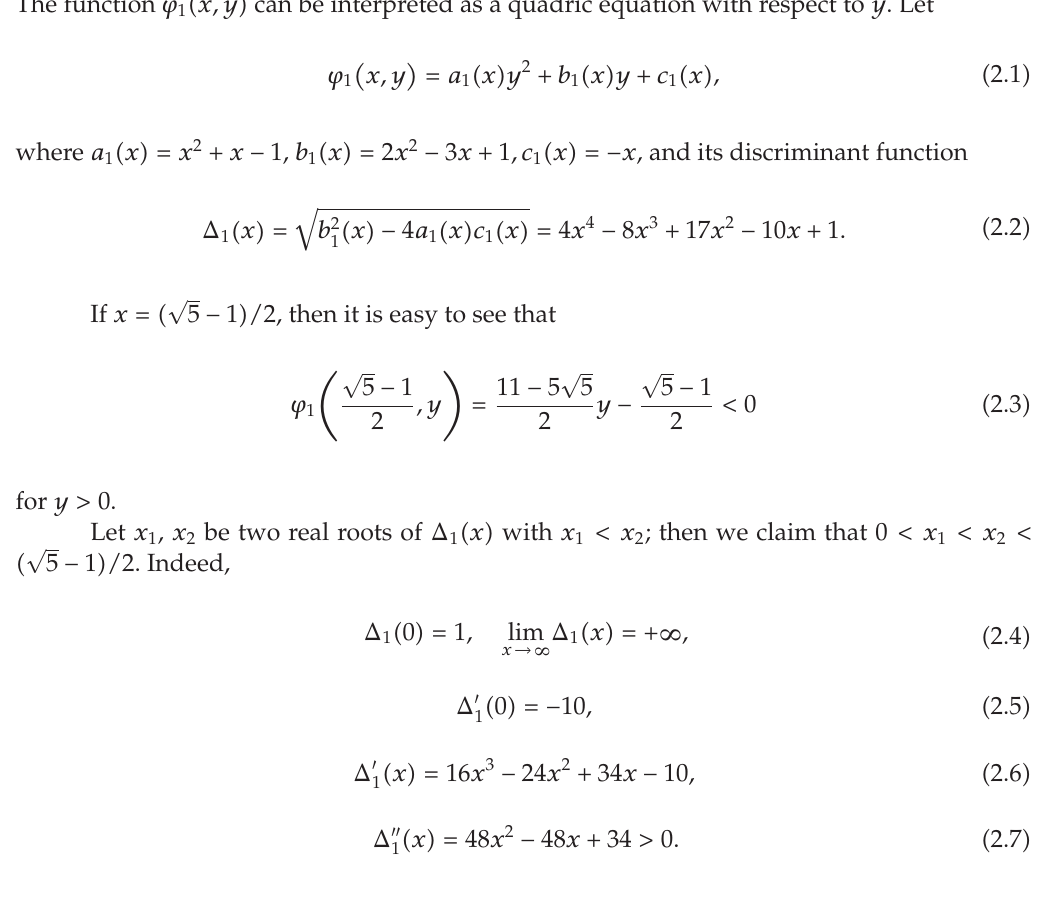
∪ Ω , and (cid:7) f α,β (cid:2) x (cid:3)(cid:8) − 1 is 1 2